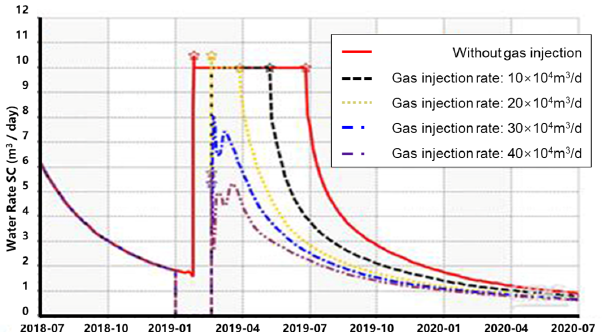
Figure 20. Effect of injection rate of pressurization on water rate.